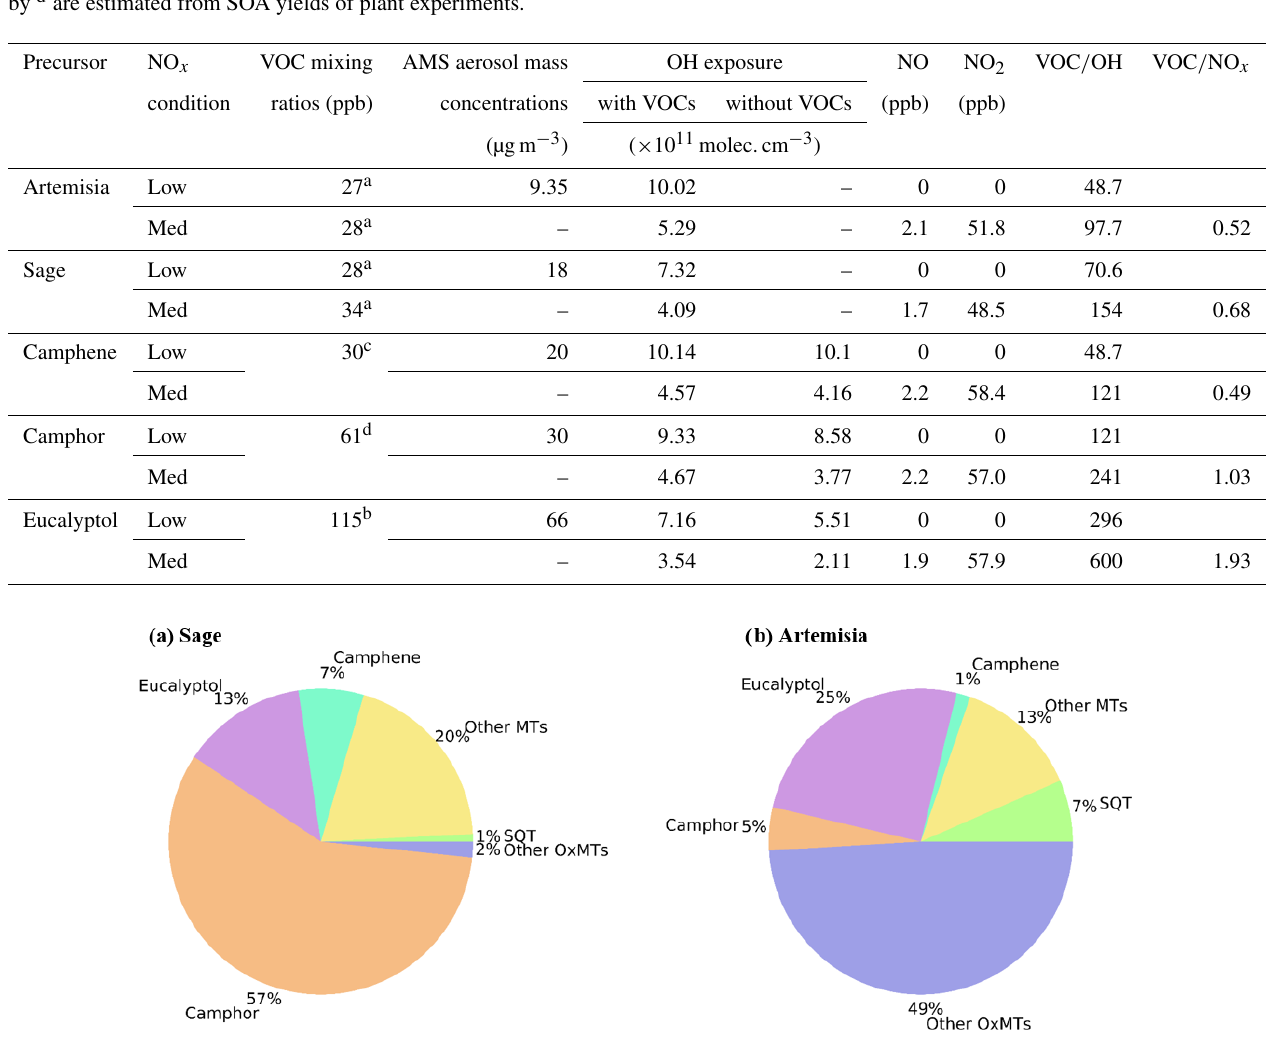
Figure 1. Volatile organic compound emission profiles of (a) Sage and (b) Artemisia where OxMTs are oxygenated monoterpenes, MTs are monoterpenes and SQT are